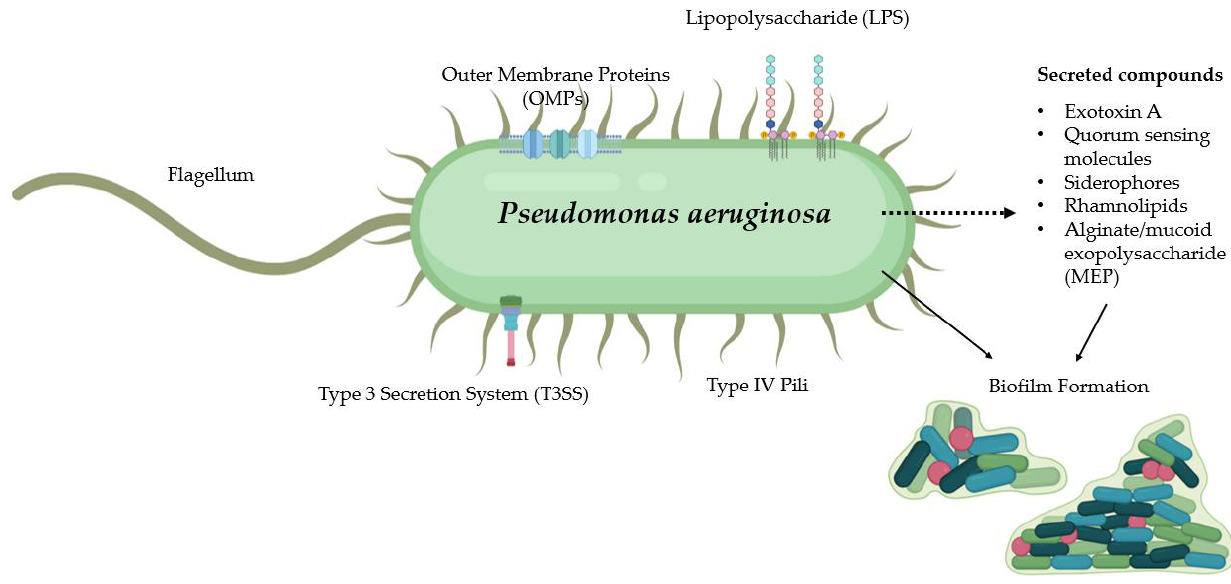
Figure 1. Key virulence factors important in the pathogenesis of P. aeruginosa infections.